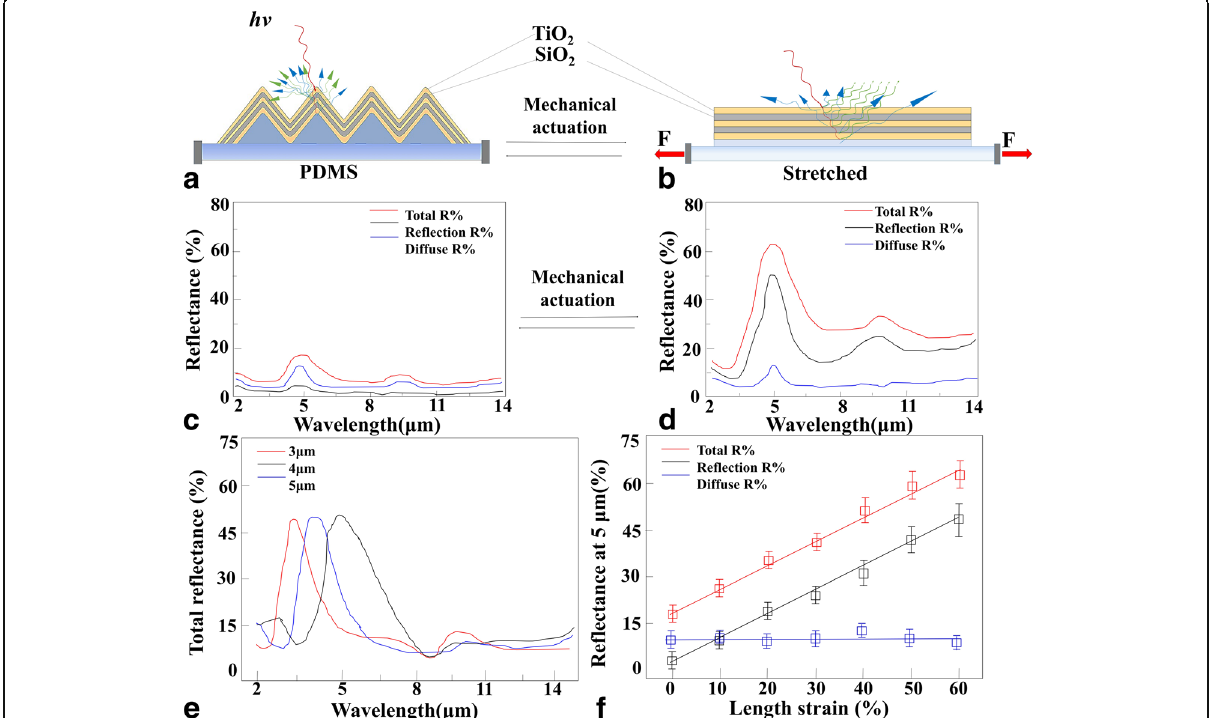
Fig. 4 Mechanical modulation of the narrowband reflectance. a The change in the surface morphology and the reflection of infrared light of a TiO 2 /SiO 2 Bragg stack-modified structures before mechanical actuation. b After mechanical actuation. c The infrared reflectance spectra of a TiO 2 / SiO 2 Bragg stack-modified structures with a peak reflectance intensity at 5 μ m before mechanical actuation. The total reflectance (red traces) are shown along with their reflection (black traces) and diffuse (blue traces) components. d After mechanical actuation. e The infrared spectra of three unactuated devices that have been designed to feature peak reflectance wavelengths of 3 μ m (red trace), 4 μ m (blue trace), and 5 μ m (black trace). f Plots of the total, reflection, and diffuse peak reflectance of the TiO 2 /SiO 2 Bragg stack-modified structures as functions of the applied length